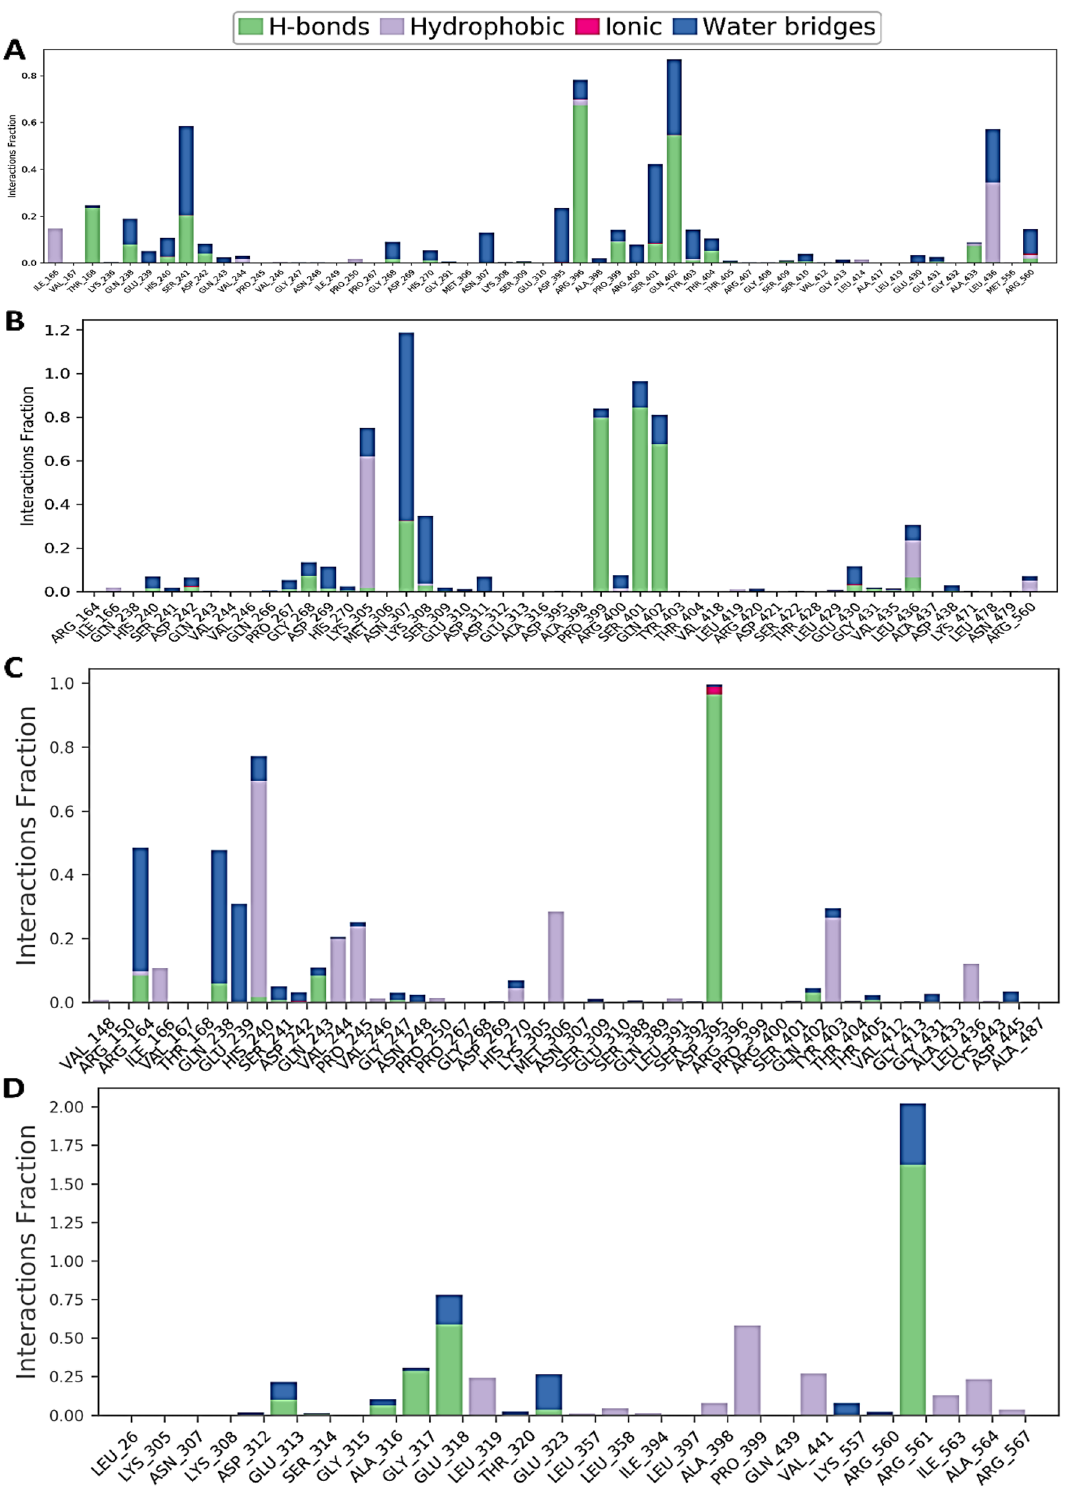
Figure 9. Graphs exhibiting the information about the protein–ligand interaction by 500 ns time of MD simulation. Herein, representing the compounds ( A ) CID_387447, ( B ) CID_3062316, ( C ) CID_9874191, and ( D )